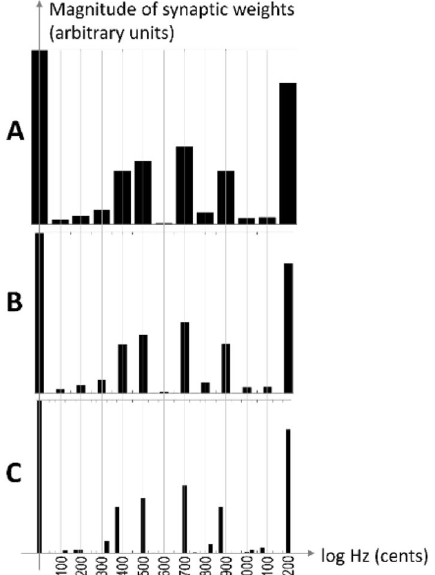
Figure 2. The discreteness and the emerged pattern seem invariant of the input sound spectrum resolution. ( A ) Input sound spectrum resolution of 100 cents. ( B ) Input sound spectrum resolution of 50 cents. ( C ) Input sound spectrum resolution of 25 cents. In C (25 cents), one can observe that additional intervals with much smaller magnitudes emerge. The MATLAB scripts used to produce these graphs are in the Supplemental Information package: ( A ) InputPerSemitone_1.m. ( B ) InputPerSemitone_2.m. ( C ) InputPerSemitone_4.m. A clue from the unpublished results from our previous study 11